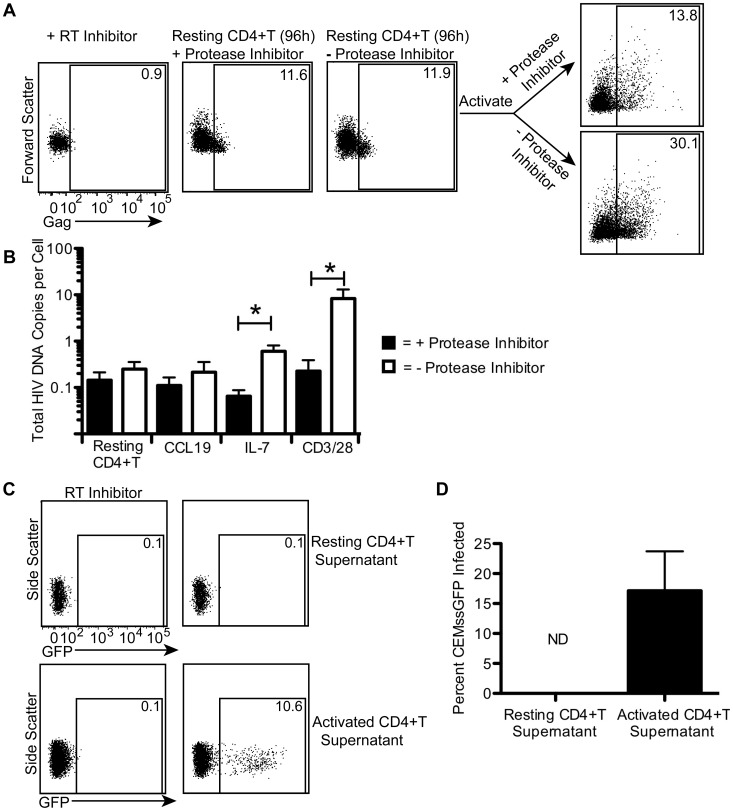
Gag expressing resting CD4+T cells remain in a latent state.In A, purified resting CD4+T cells were spinoculated with NL4-3 (MOI of 3) and cultured in the presence or absence of saquinavir for 4 days. Intracellular Gag was measured 96 hours post infection. Control cells were treated as in A and gates were set using an efavirenz treated control. Then resting cells cultured without saquinavir were stimulated with PHA+100 U/mL IL-2 for 48 hours in the presence or absence of saquinavir. Intracellular Gag was again measured. In B, cells were purified and treated as in Figure 1 but infected at a MOI of 0.2. After infection, half the cells were treated with saquinavir. Cells were collected at 72 hours for CD3/28 activated cells and at 7 days post infection for all other cells. Total DNA was measured in both fractions of cells. The average of 3 experiments with 3 different donors is shown. In C, resting and CD3/28 activated cells were spinoculated with HIV (MOI of 3). Supernatant was collected 96 hours post infection. CEMss-GFP cells were spinoculated with the collected supernatant from resting and activated cells. An efavirenz control was used to determine background GFP levels. A representative experiment is shown in C. An average of 2 experiments in 2 different donors is shown in D. Error bars represent the standard error of the measurements. *Statistically significant at p<0.05 level. ND = not detectable.